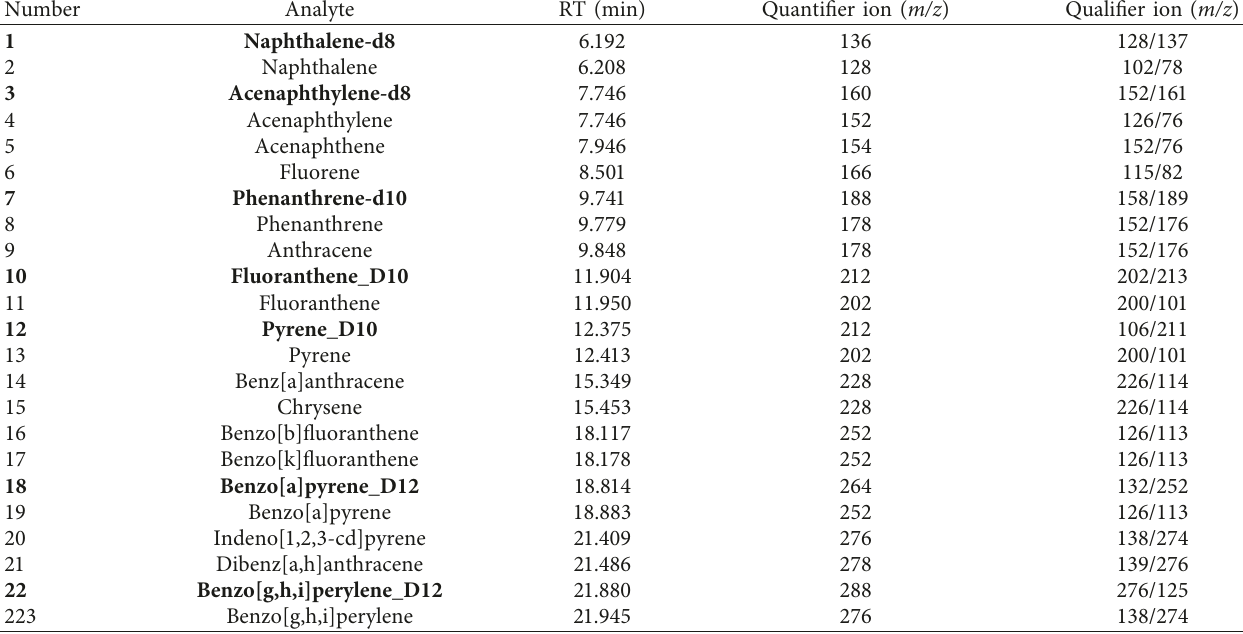
Table 1: Retention time, quantifier ions, and qualifier ions ( m/z ) for target PAHs and